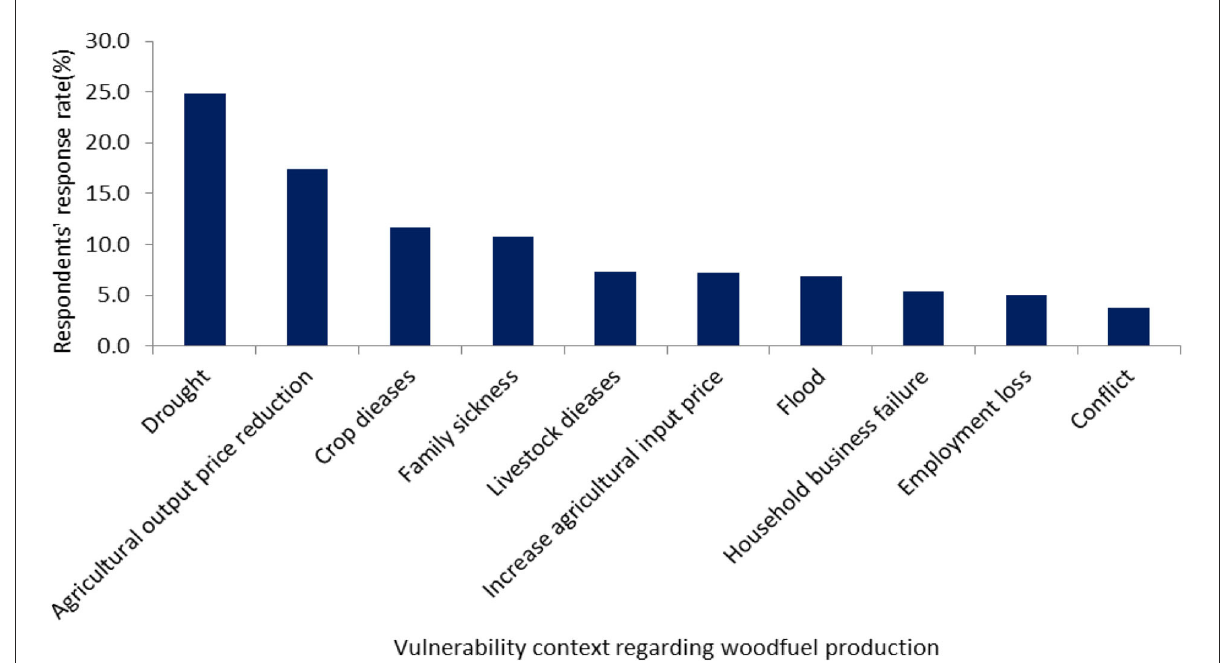
FIGURE3 Vulnerability context.